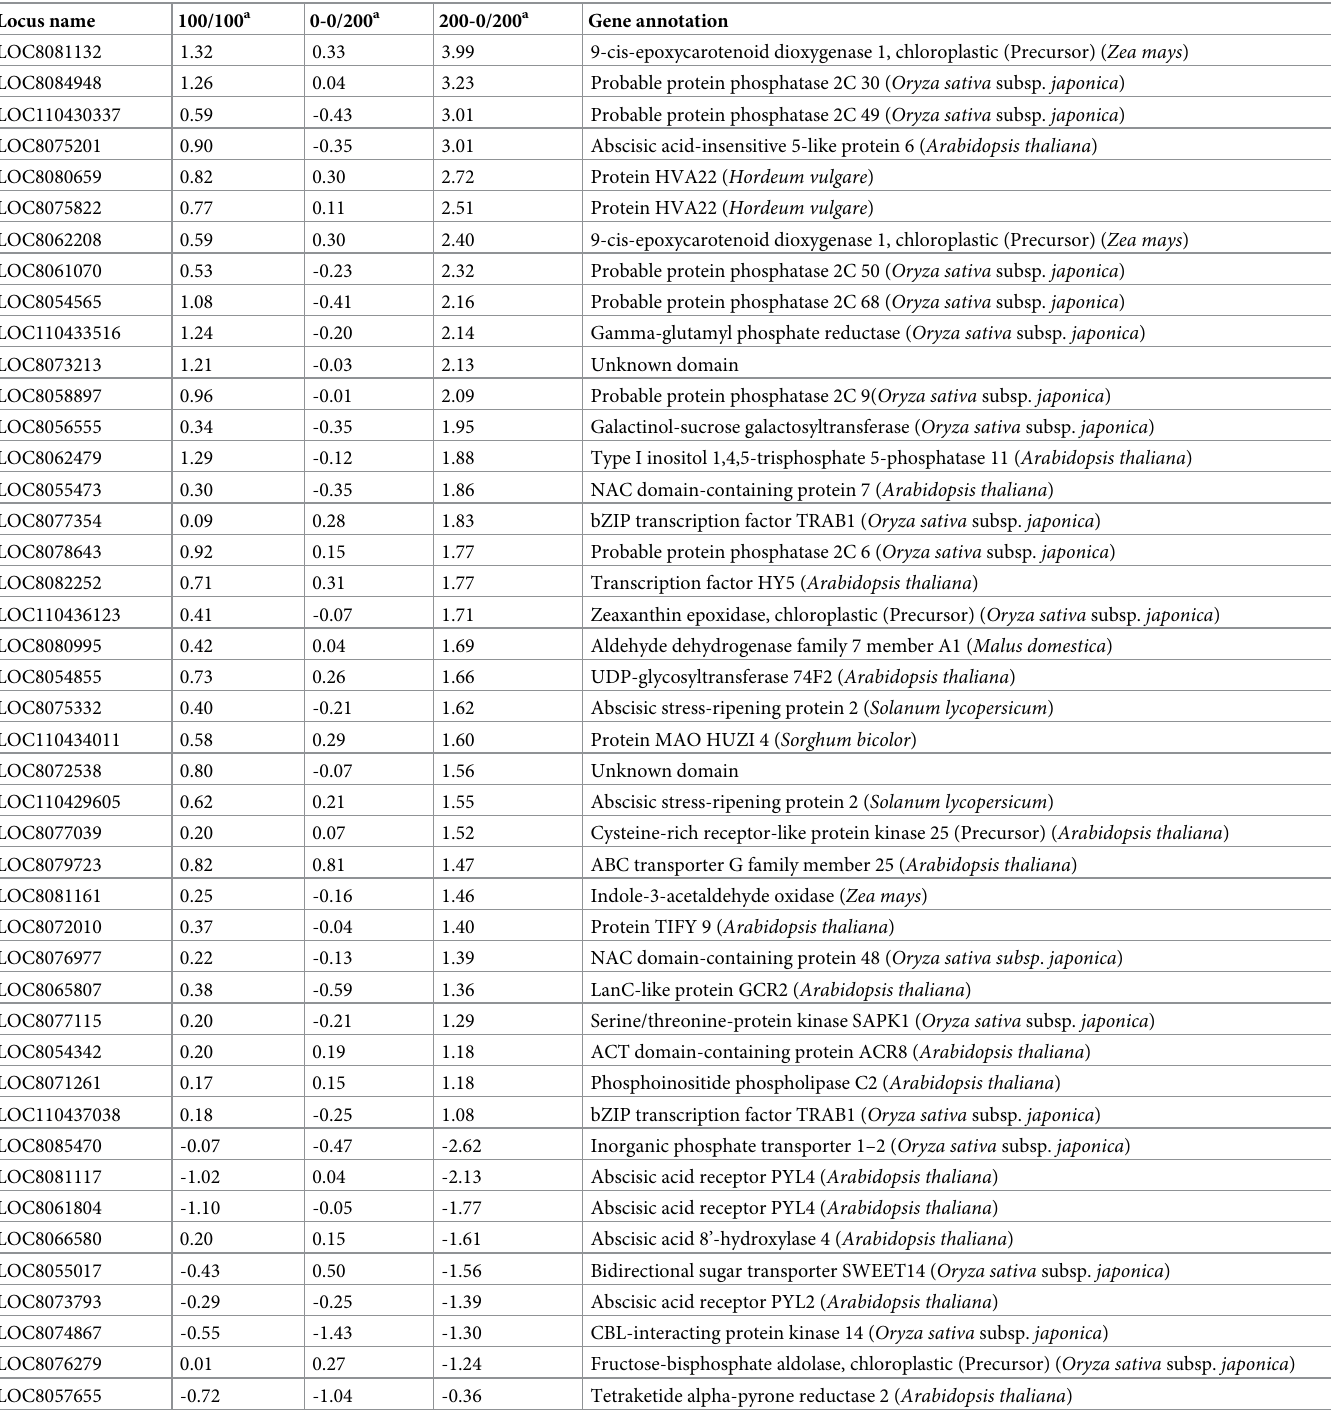
Table 2. Summary of differentially expressed ABA related genes in roots under uniform and non-uniform salinity treatments. Locus